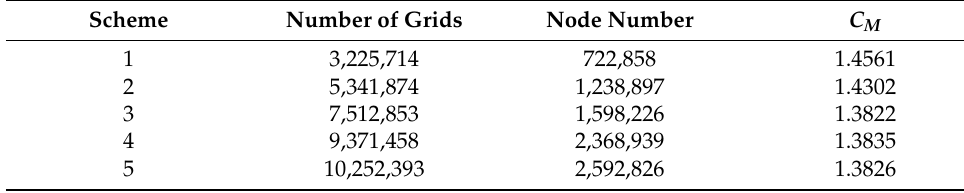
Table 2. Grid independent verification scheme.